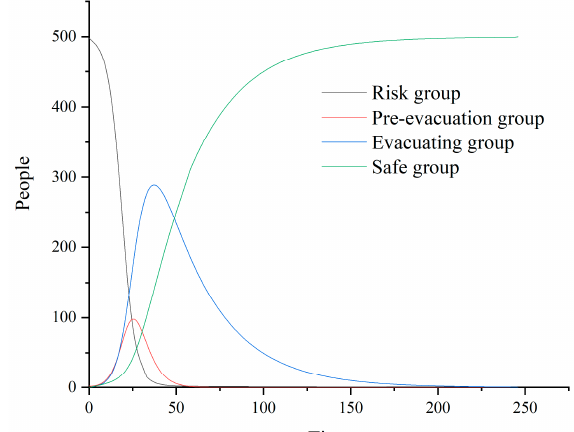
Figure 6. Graph of changes in numbers by group.